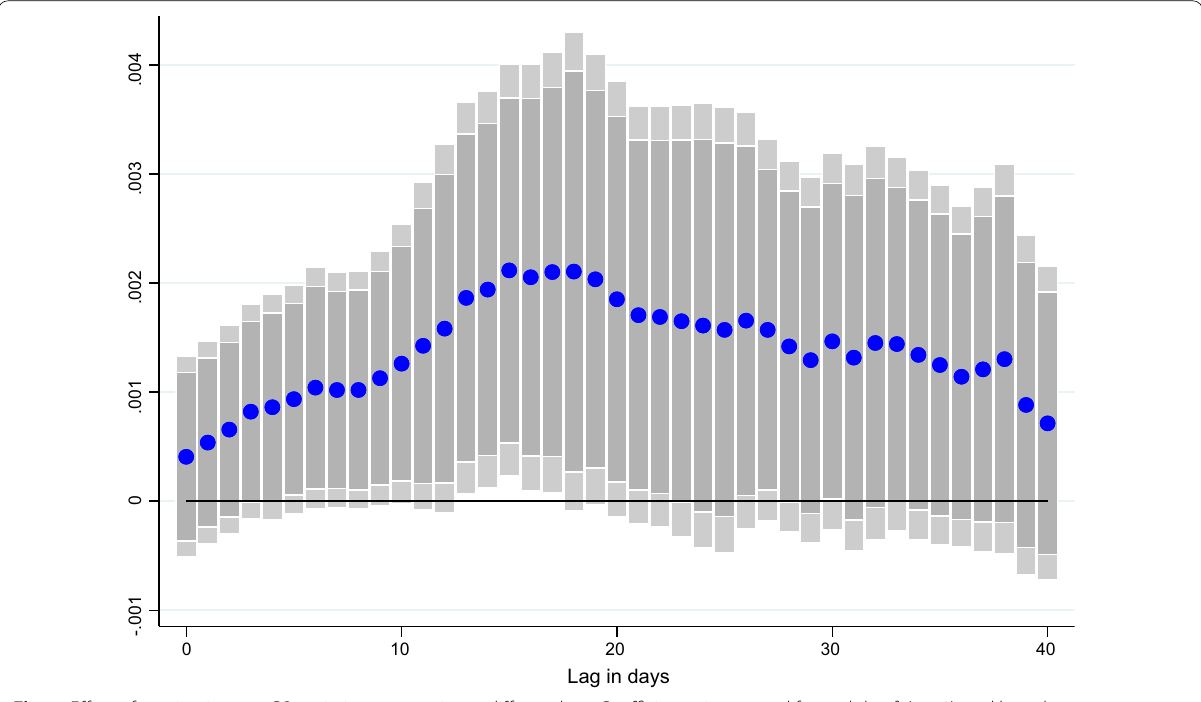
Fig. 4 Effect of vaccinations on CO emissions per capita, at different lags. Coefficient β is reported for each lag ℓ (1–40), and based on � Y i , t = α + µ i + γ t + β SV i , t − l + θ X i , t − l + ε i , t for a sample of 44 countries using daily data from December 20, 2020–June 16, 2021. Y i , t denotes CO emissions per capita and SV i , t − l is the surprises in vaccines administered (per capita). µ i and γ t are the country and time fixed effects. X is a vector of control variables which includes the level of new cases, NO 2 and CO emissions per capita, the stringency of containment measures index, and mobility indices at t-1 . Lightly shaded bars denote 90 percent confidence bands, and dark-shared bars denote 95 percent confidence